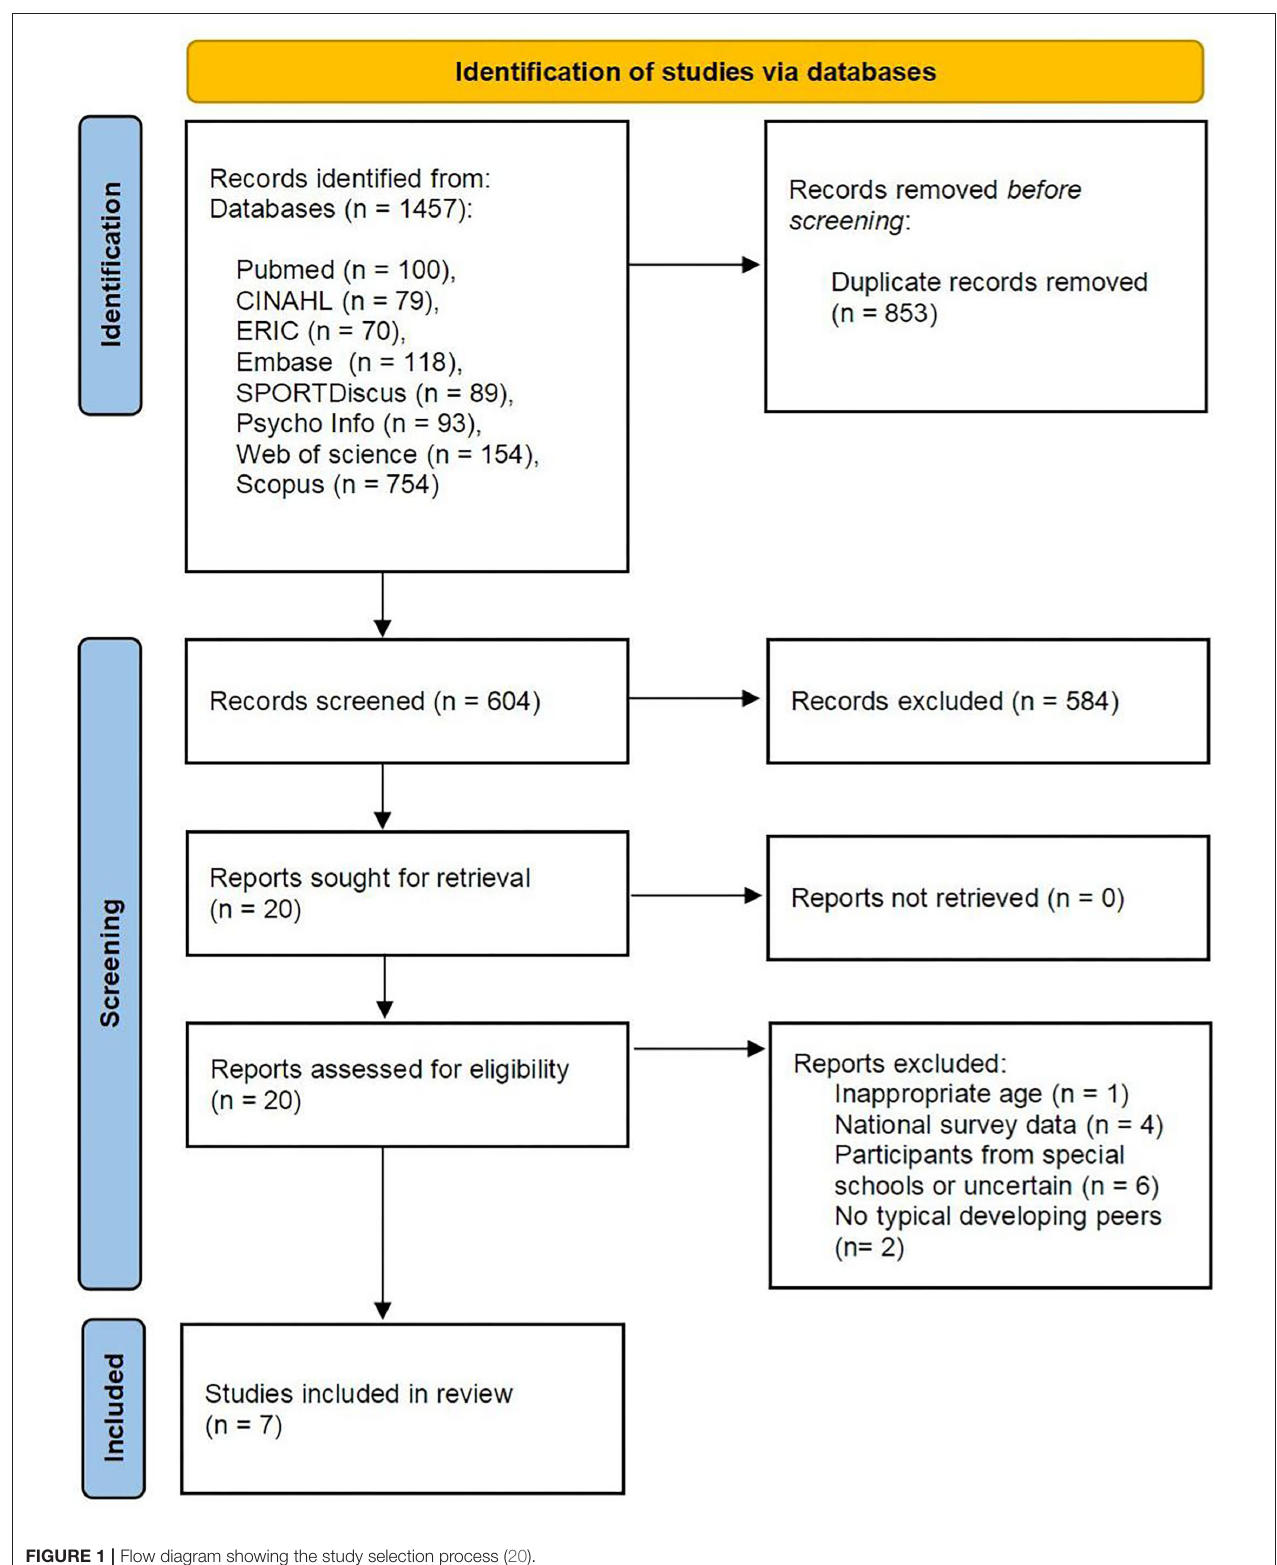
FIGURE 1 | Flow diagram showing the study selection process